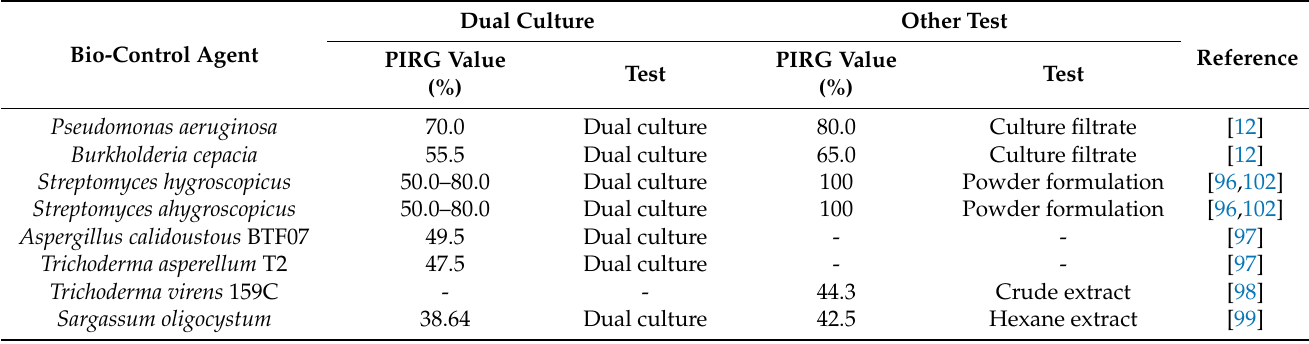
Table 4. In vitro test of bio-control agents against G. boninense